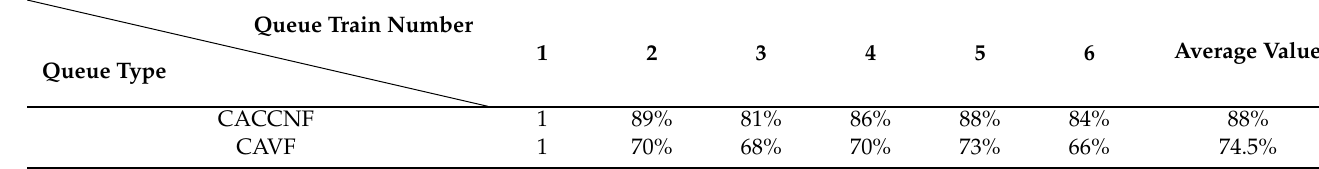
Table 8. Comfort degree of CAVF fleet and CACCNF fleet.